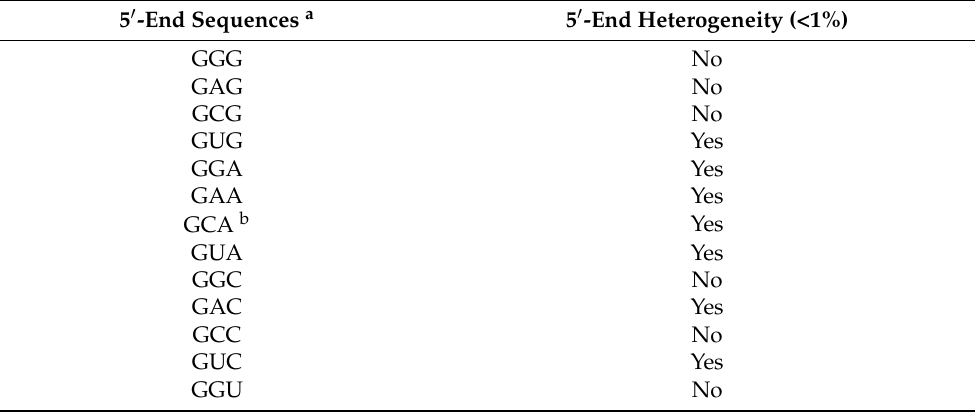
Table 4. Sequences requirements for maximum RNA 5 (cid:48) -end homogeneity in T7 RNA polymerase in vitro